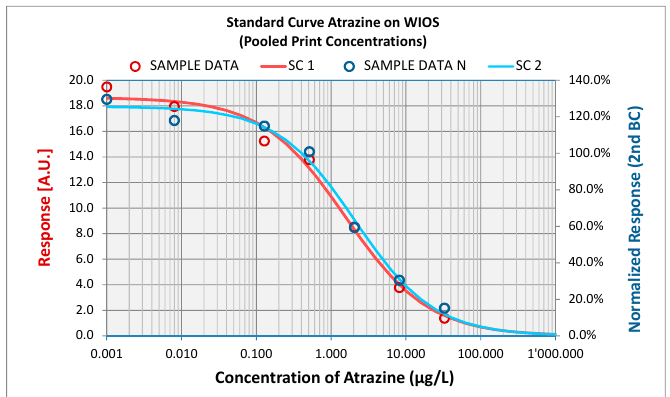
Figure 3. Fitting to sample data with an atrazine calibration series. The red fit curve corresponds to pad pooled response values without built-in calibration (in Arbitrary WIOS Units), the blue curve to calibrated data (in %, right y -axis) using the second response curve in the assay (see above). Note that in the following percentage values always correspond to normalized responses using the built-in